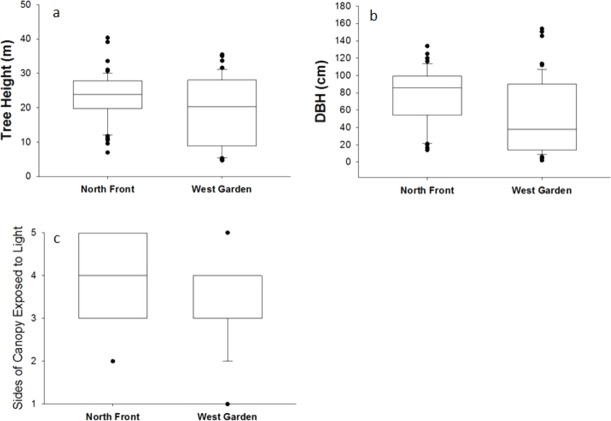
Tree characteristics and differences between the North Front and West Garden: (A) Tree height (z =  − 2.13, P < 0.05); (B) DBH, (z =  − 3.66, P < 0.0005); (C) sides of canopy exposed to light (z =  − 4.11, P = 0.0001).